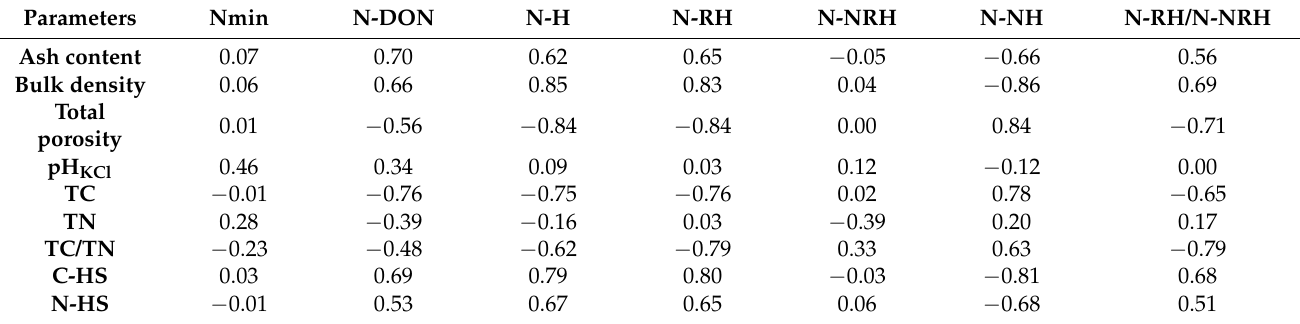
Table 8. Correlation of the share of nitrogen fraction with soil